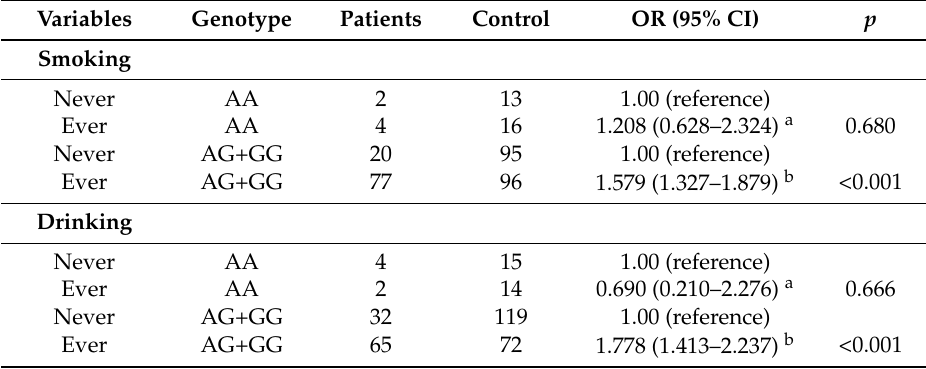
Table 6. The interaction between smoking or drinking and rs4148323